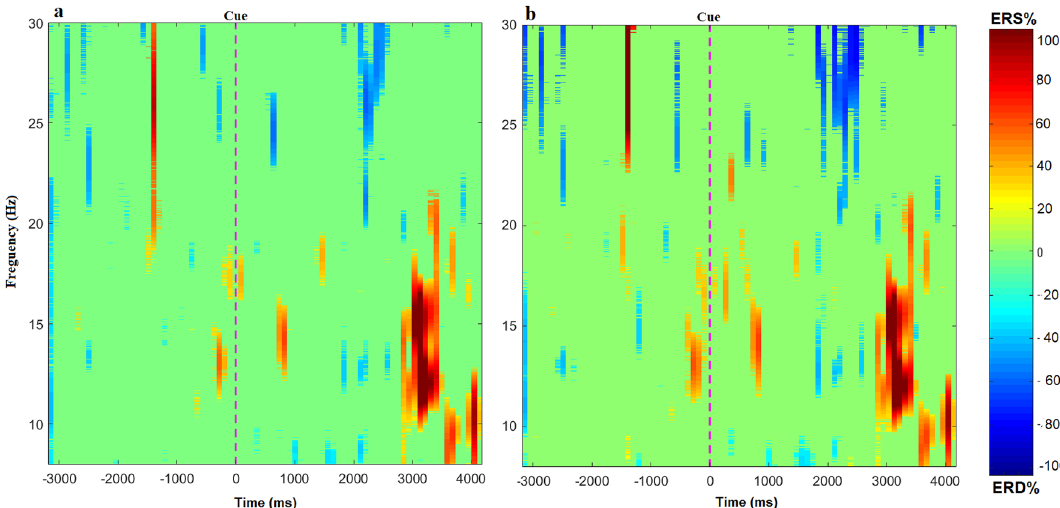
Figure 1. Time-frequency representation shows the grand average of event-related (de)synchronization (ERD/ ERS). ( a ) The ERD/ERS in the contralesional hemisphere. ( b ) The ERD/ERS in ipsilesional hemisphere. ERD is indicated by the blue colors, whereas ERS is indicated by the red colors.